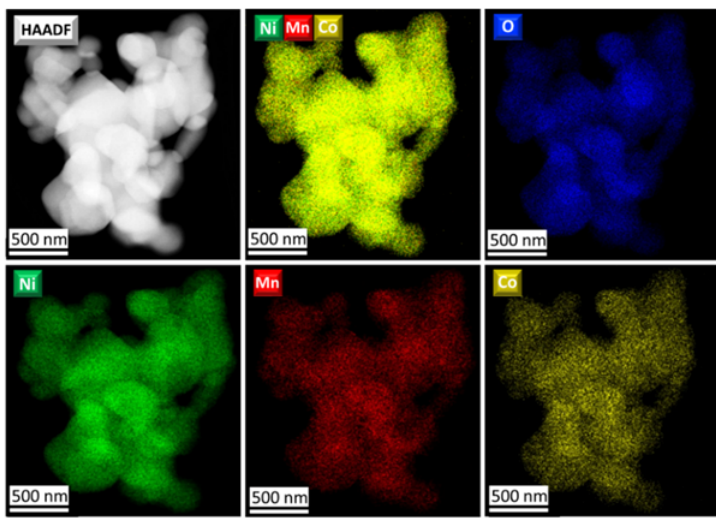
Figure 6. HAADF-STEM image of the MW_30m_A NMC811 sample along with the corresponding color-coded STEM-EDX compositional map and elemental maps of O, Ni, Mn, and Co. Table 2. ICP-MS and EDX quantitative elemental analysis for the NMC811 samples obtained via different routes.